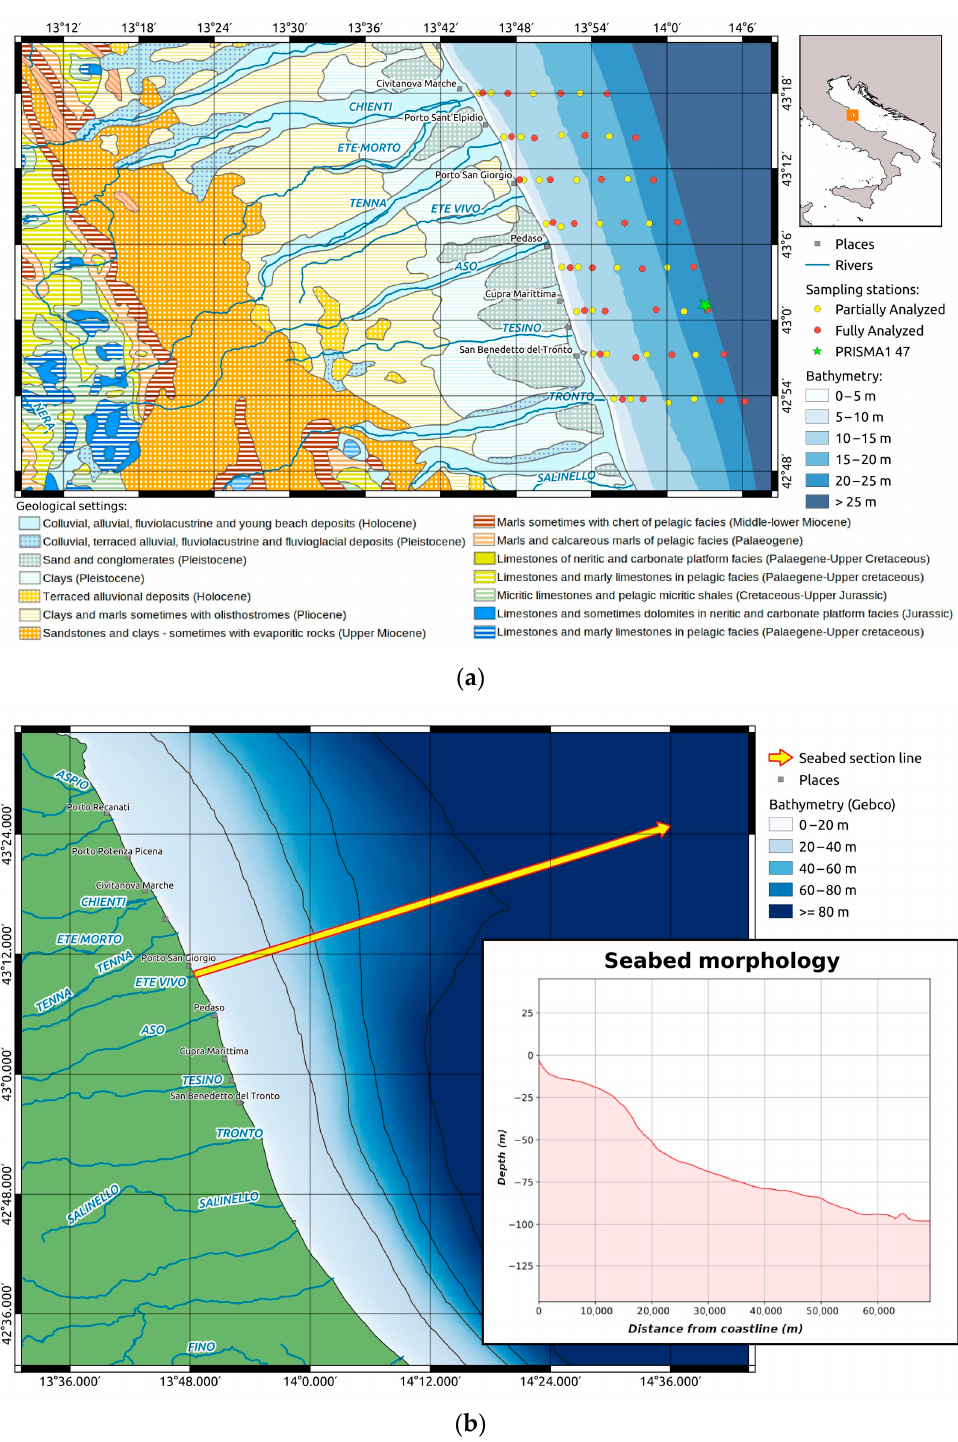
Figure 2. Study area with the mainland geological setting and sampling stations, red and yellow dots, respectively ( a ); topographic section along the study area ( b ). The map has been generated using QGIS 3.10.4-A Coruña. Rivers courtesy of ISPRA (http://www.sinanet.isprambiente.it/it/sia-ispra/download-mais/reticolo-idrografico/view), and the geological setting courtesy of Geoportale Nazionale (http://www.pcn.minambiente.it/viewer/).